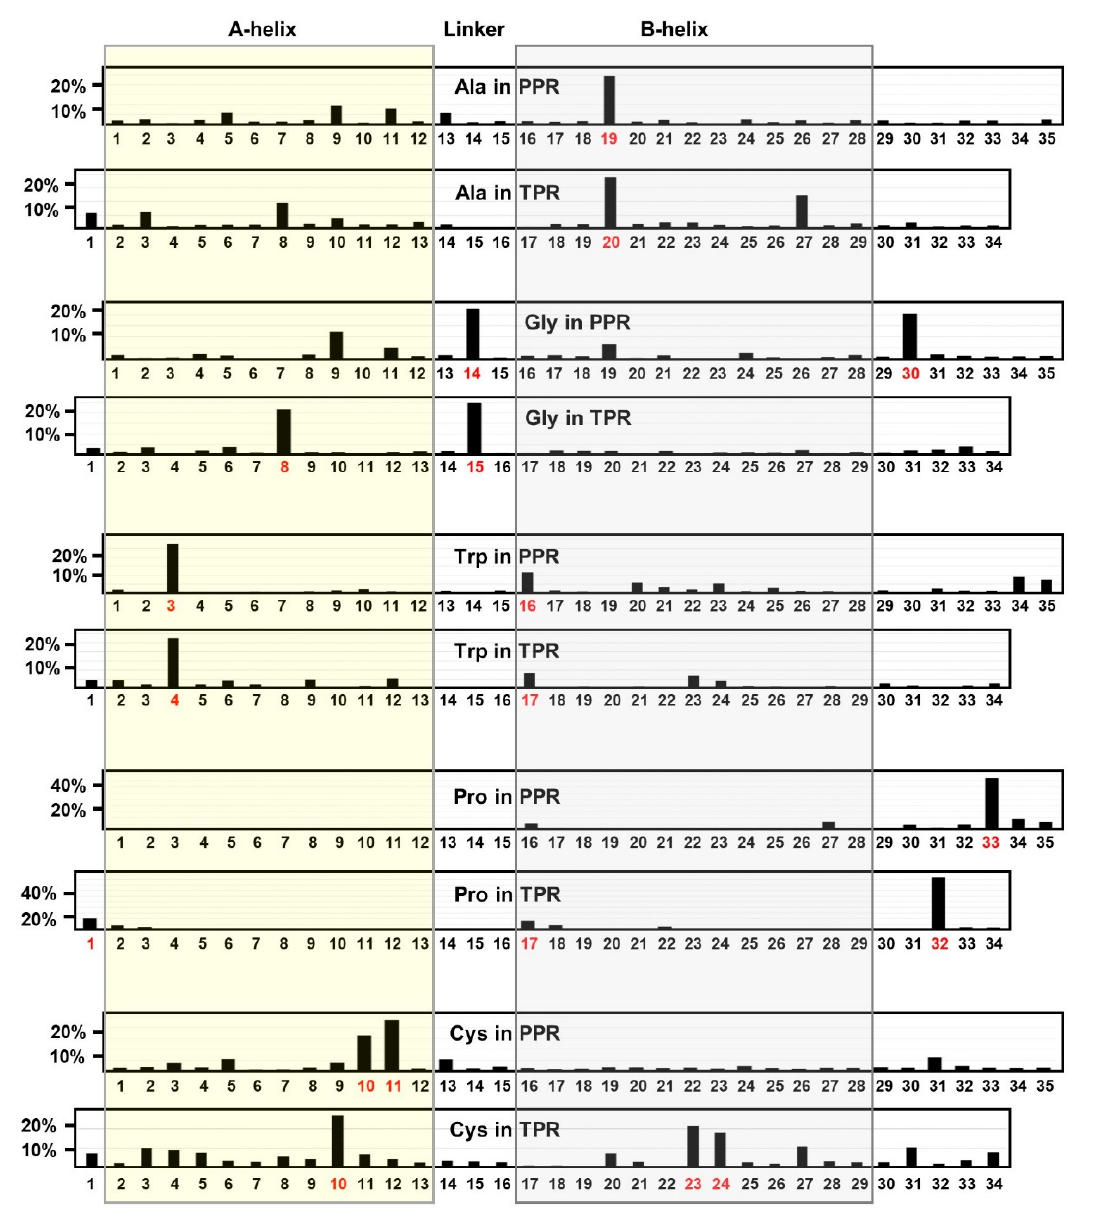
Figure 1. Positional distribution of individual amino acids over penta- and tetra-tricopeptide repeats. Naturally occurring tetra- and penta-tricopeptide repeat sequences (a total of 22,999 PPRs and 1137 TPRs) retrieved as described previously [10] and in the Materials and Methods. For each amino acid, the total number in each position of the repeat is counted using Excel, and plotted as the percentage of the total number of that amino acid in all positions (35 in PPR and 34 in TPR). For example, the percentage of Ala at any PPR position is = (Na/Nt) × 100, where Na is the number of Ala at a given position a in all PPRs, and Nt is total number of Ala in all positions in all PPRs. Note the Y-axis scale for Pro is higher because the bulk of it (~50%) is present at a single position (as Pro33/Pro32), which in fact serves as a signature for these repeats [2–4,10]. Numbers in red on the X-axis indicate the major site(s) of concentration of a residue. A-helix and B-helix are boxed in transparent yellow and grey, respectively, with the linker sequence in the